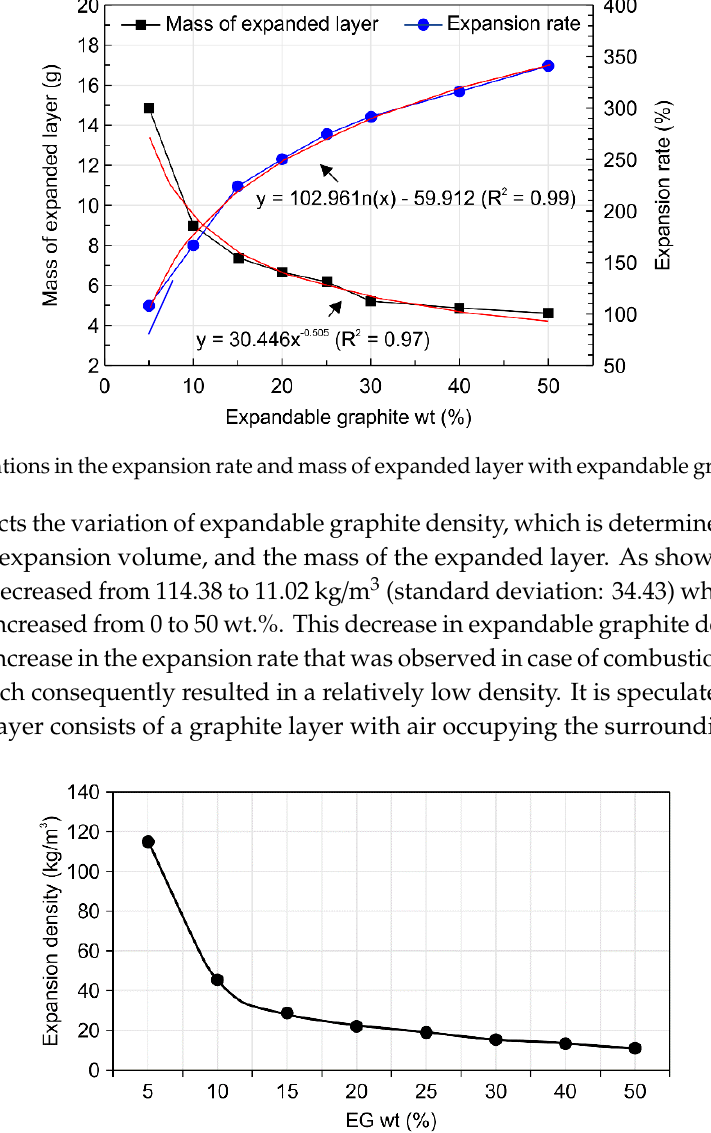
Figure 9. Variation in expanded graphite density with the expandable graphite content.